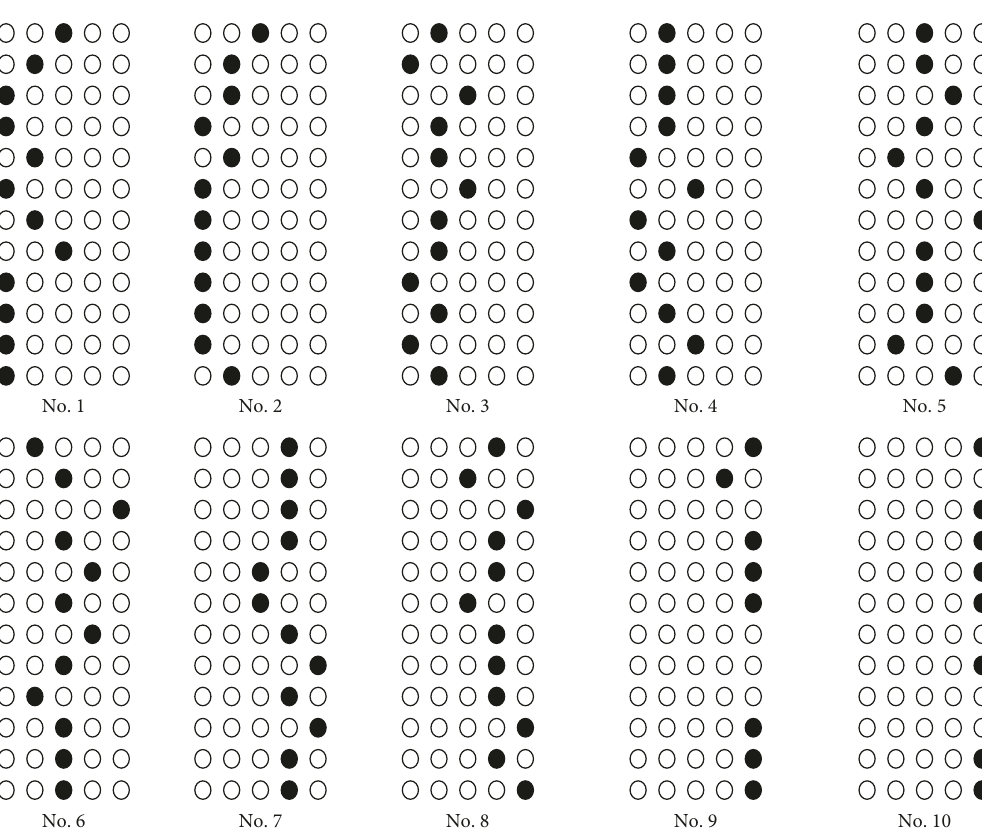
Figure 3: Coding of evaluation indicators for the 10 samples to be classified. Table 5: Evaluation indicators for the 10 samples to be